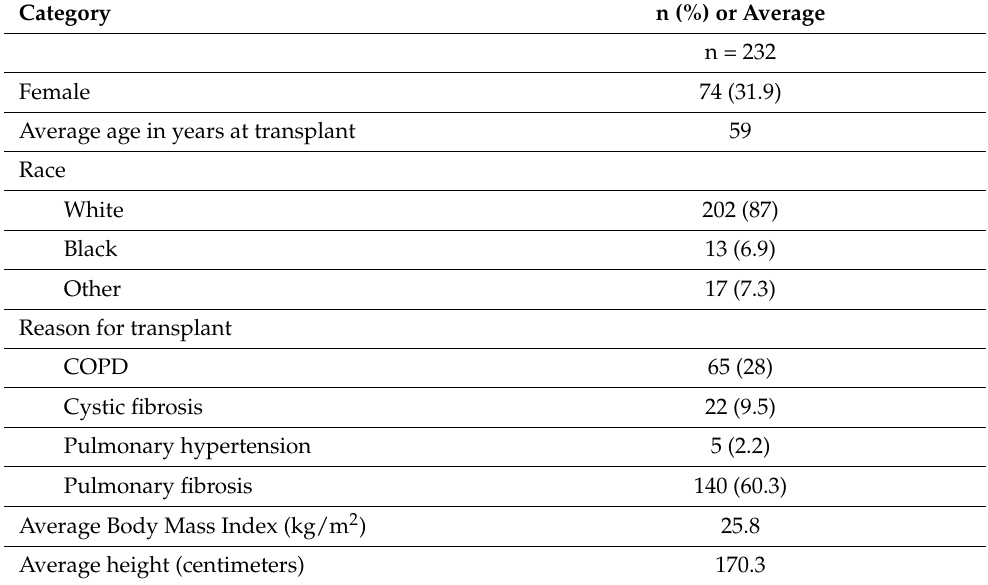
Table 1. Demographics.